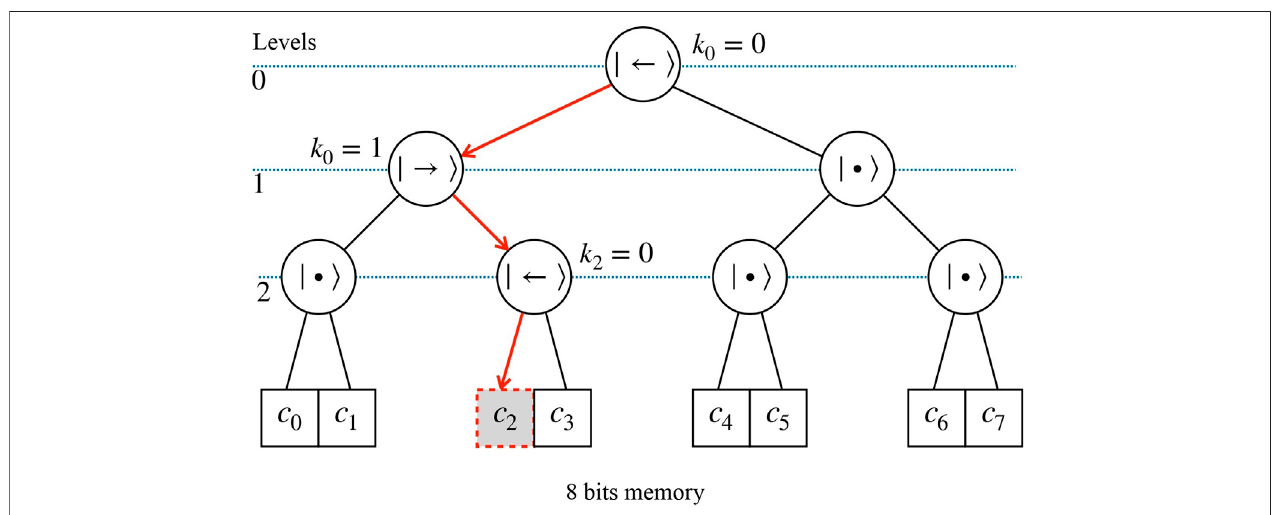
FIGURE 2 | Schematic representation of the BB architecture for a eight states qRAM. To address the memory cells only 3 (cid:1) log 2 (8) are needed. The nodes of the treearecomposedbyqutrits,whichareinitiallyinthewaitstate.Thebitstringdeterminesthepathtobefollowedbythebussignal,inwhich0meansleftpathand1right path.Dependingonthebitsofthegivenstring,thestatesofthequtritsareleftin | ← 〉 or | → 〉 ,andfollowstothenextlevel.Adaptedfrom[38].Afterreturningbythesame path to the beggining of the tree, the states return to the wait states.